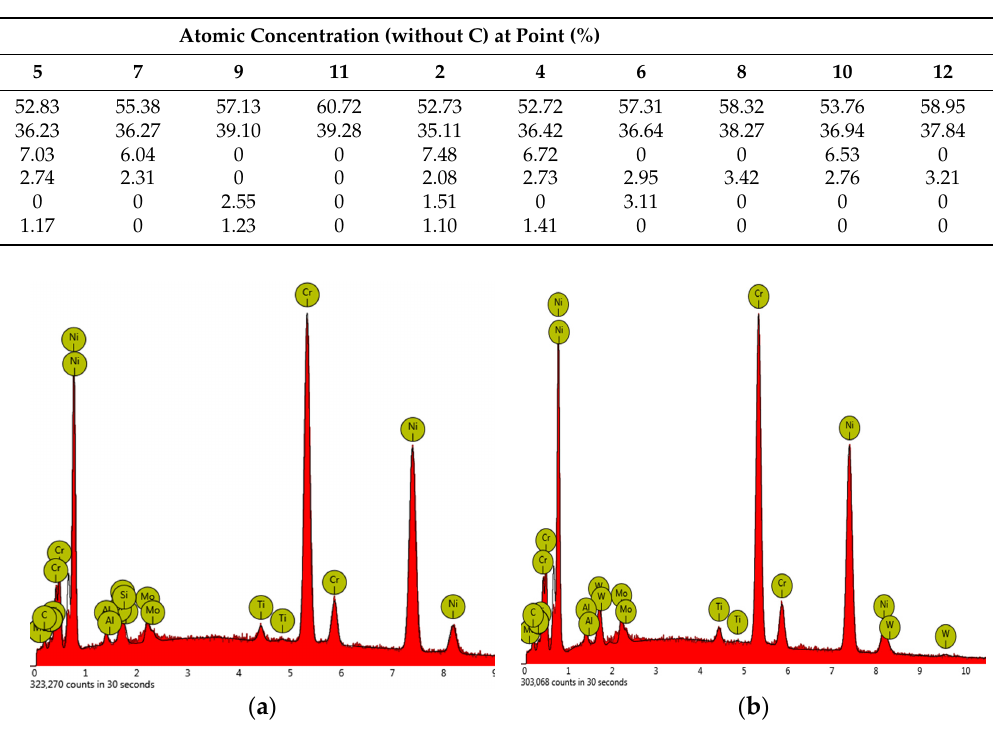
Figure 7. Typical data of trace element EDS analysis with SEM: ( a )—at point 6, ( b )—at point 5 of a structure (Figure 6).